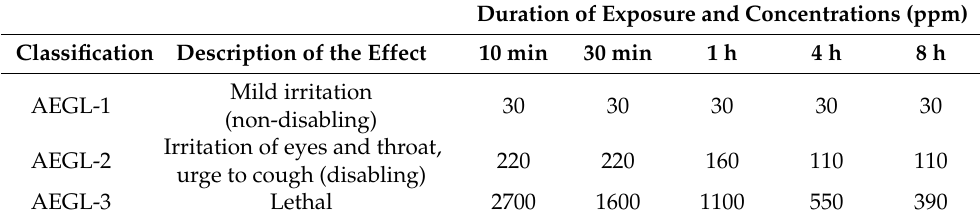
Table 5. Ammonia acute exposure guideline levels—effects on health